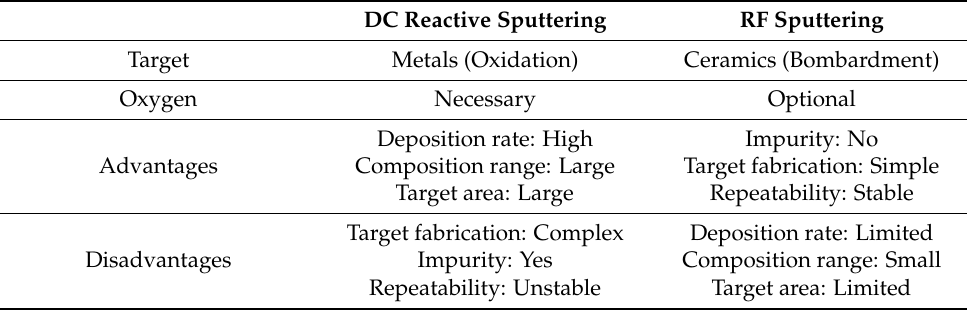
Table 2. Comparisons of RF sputtering and DC reactive